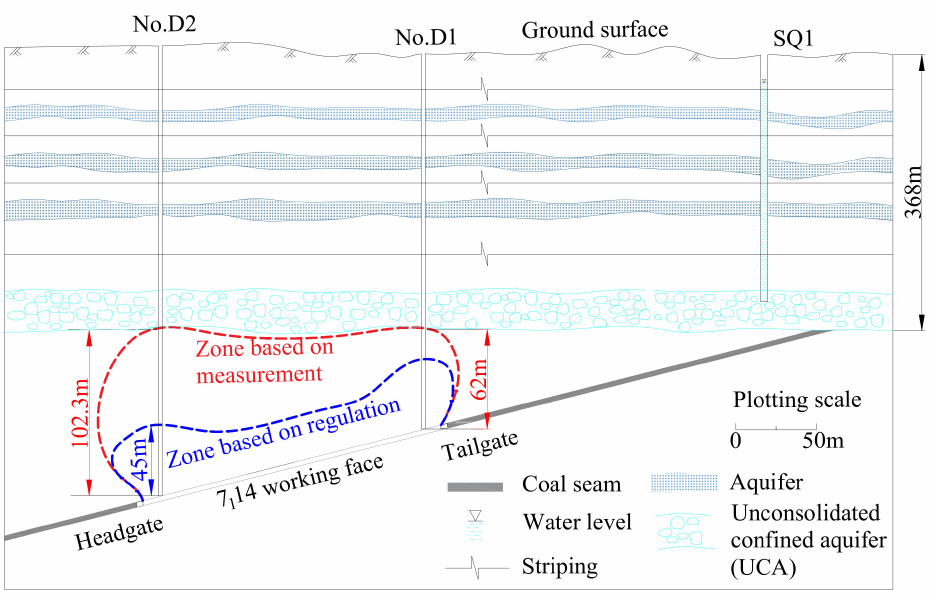
Figure 10. Drilling results of water flowing fracture height in 7 1 14 working